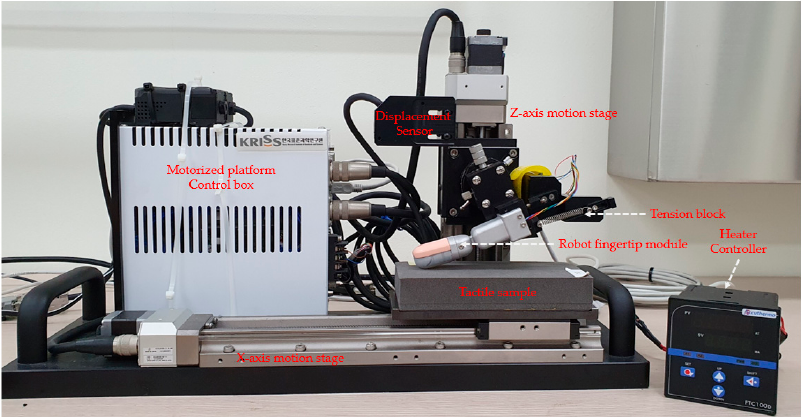
Figure 2. Photo showing the experiment of measuring a hard sponge (# 12) sample with a motorized texture discrimination platform equipped with a robot fingertip module.